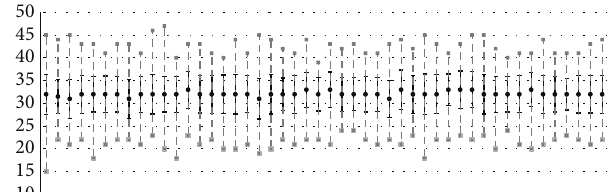
Figure 1: Avalanche analysis of 𝑋 (𝑡) matrix block.